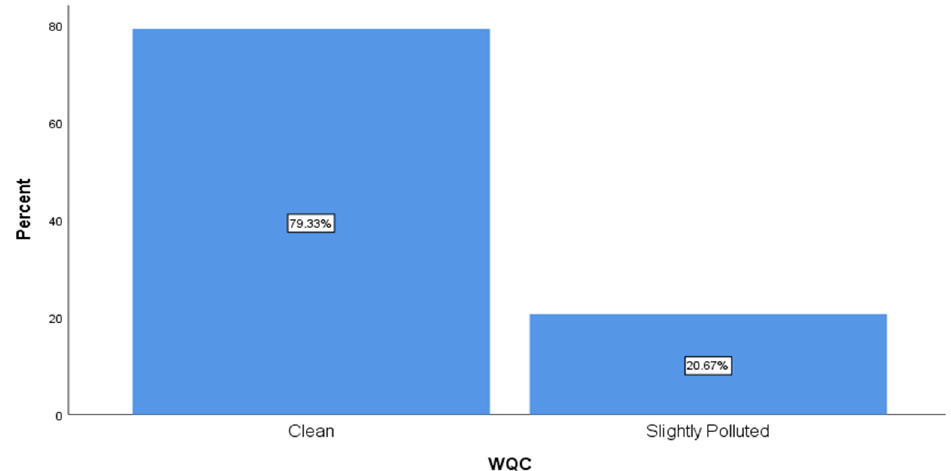
Figure 3. Bar chart for water quality classification.